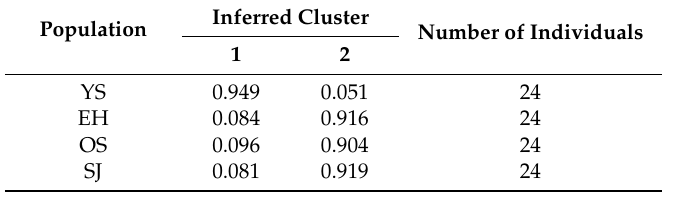
Table 5. Proportion of eight populations in each of the two inferred clusters.